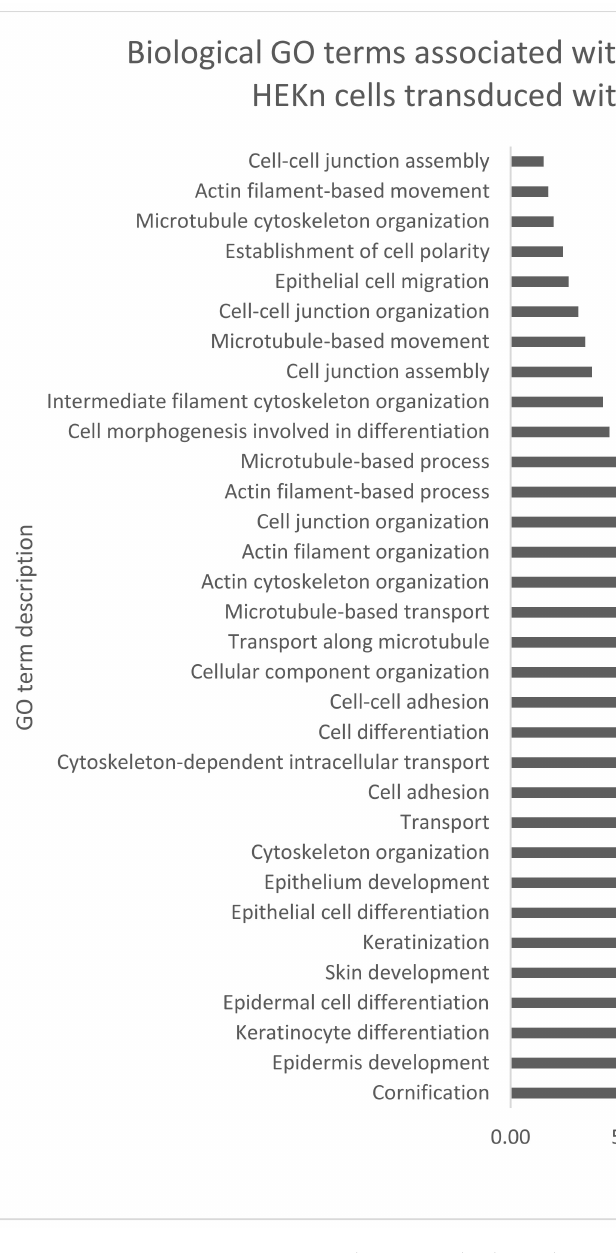
Figure 6. Thirty two- biological GO terms associated with epidermal differentiation, adhesion and cytoskeletal organization were predicted to be related to proteins with a reduced expression by ≥± 1.5-fold change (adjusted p -value ≤ 0.02) in keratinocytes transduced with HPV16 E6 and E7 FDR (False discovery